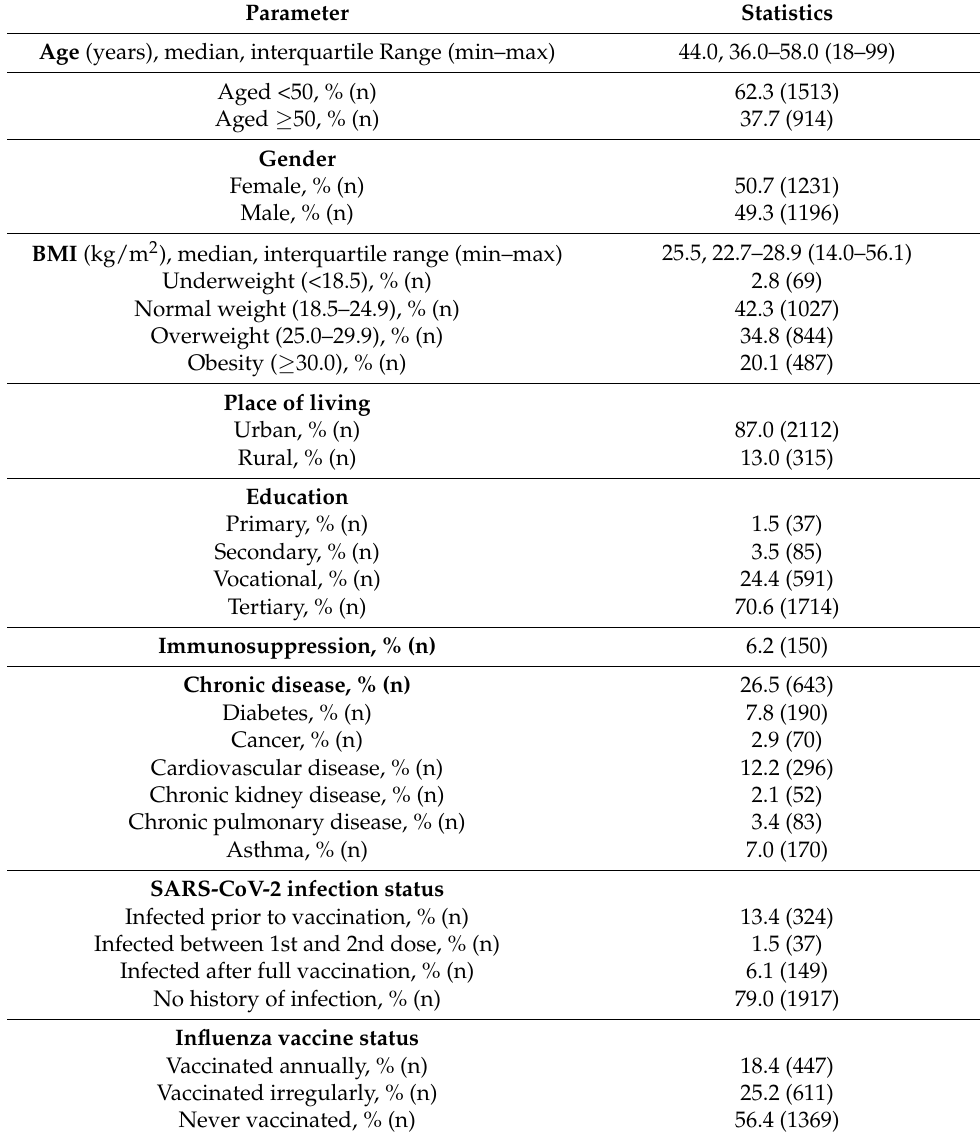
Table 1. Summary of the demographic characteristics of the studied group ( n =